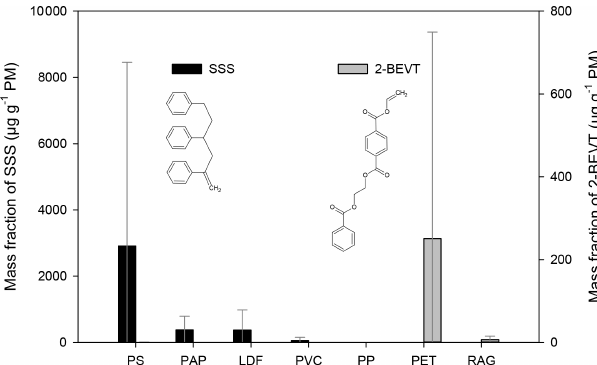
Figure 2. The mass fraction (in units ofµgg − 1 PM) of styrene trimer (SSS) and that of the 2-(benzoyloxy)ethyl vinyl terephtha- late (2-BEVT) from the burning of different waste types. The error bars represent the standard deviation of the EF data obtained for a given type of waste under different burning